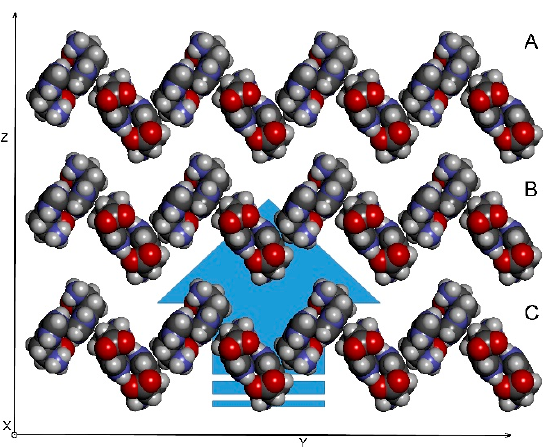
Figure 10. An assembly of 2D-sheets into the final 3D structure. The coordinate system depicted was chosen arbitrarily and has only illustrative function.